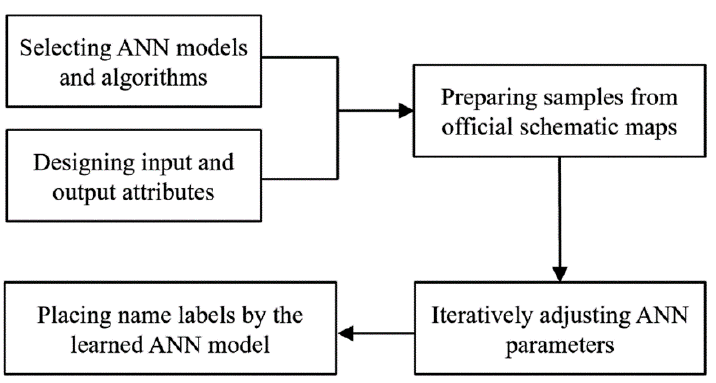
Figure 2. The process of using ANNs for automated labelling of schematic maps.